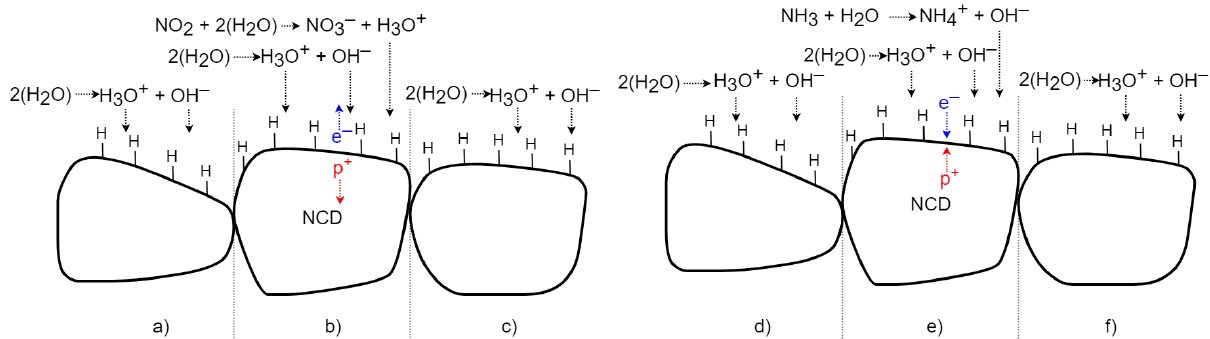
Figure 15. Schematic time process of gas interaction between the H-terminated NCD and oxidizing and reducing gases.